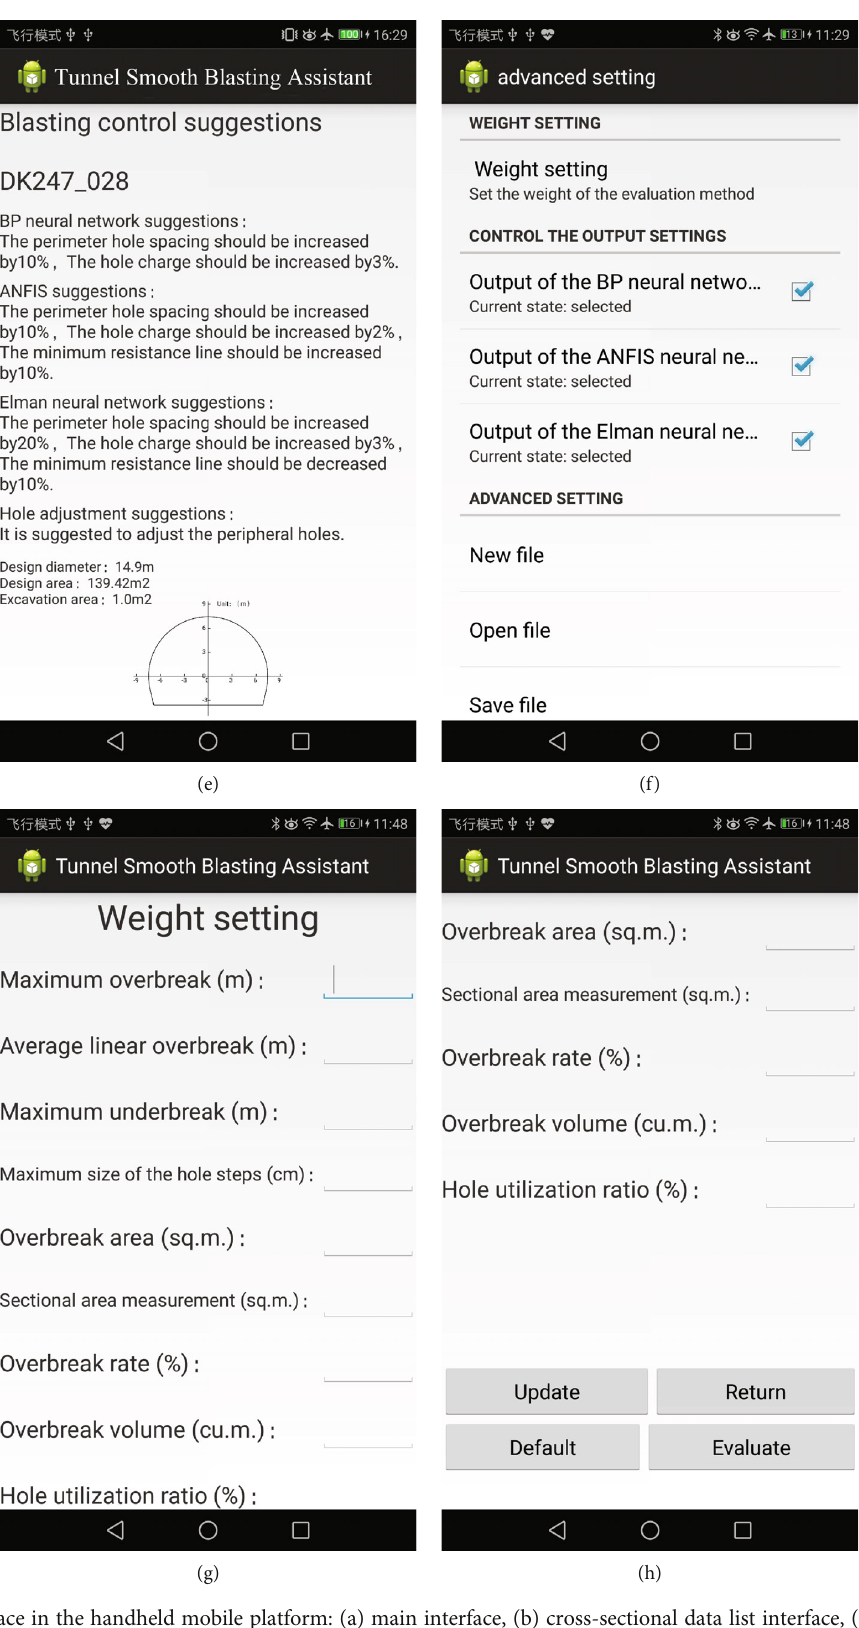
Figure 5: User interface in the handheld mobile platform: (a) main interface, (b) cross-sectional data list interface, (c) interface of section addition and update, (d) evaluation interface, (e) control interface, (f) advanced settings interface, (g) fi rst page of weight setting interface, and (h) fi rst page of weight setting